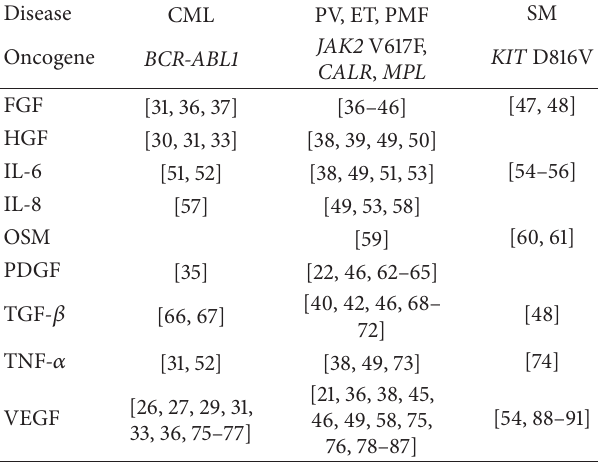
Table 1: Increased expression of cytokines in myeloproliferative neoplasms. Evidence for increased expression of the cytokines fibroblast growth factor (FGF), hepatocyte growth factor (HGF), interleukin-6 (IL-6), IL-8, oncostatin M (OSM), platelet derived growth factor (PDGF), transforming growth factor- 𝛽 (TGF- 𝛽 ), tumor necrosis factor- 𝛼 (TNF- 𝛼 ), and vascular endothelial growth factor (VEGF) in the myeloproliferative neoplasms chronic myeloid leukemia (CML), polycythemia vera (PV), essential thrombo- cythemia (ET), primary myelofibrosis (PMF), and systemic masto- cytosis (SM) is shown. The numbers indicate selected references for elevated expression of the cytokine in the given myeloproliferative